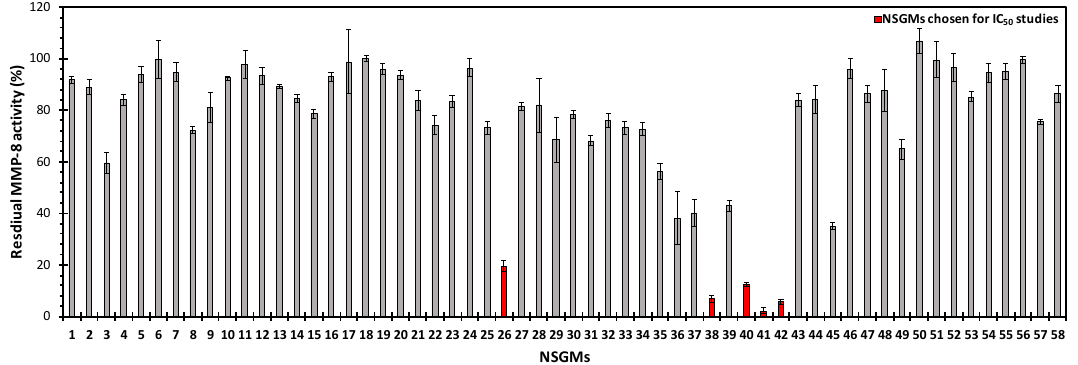
Figure 3. Residual activity of MMP-8 (10 nM) in the presence of each NSGM (100 µM) in Tris-buffered saline containing 10 mM CaCl 2 , 1 µM ZnCl 2 , pH 7.5 for 10 min at 37 °C. The residual MMP-8 activity was measured using a fluorogenic substrate. All of the measurements were performed at least in duplicate. Error bars represent ± 1 standard deviation (SD).